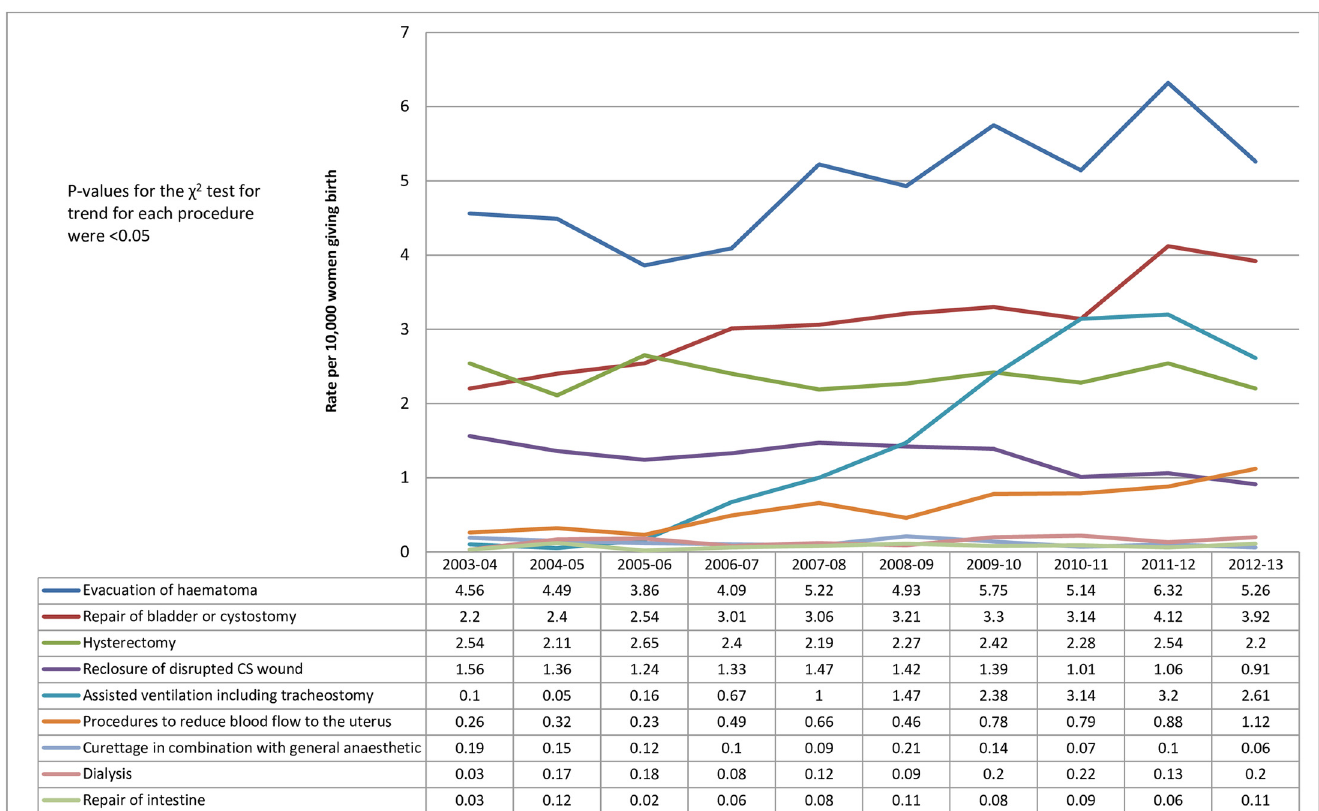
Fig 5. Annual rate per 10,000 women of the individual procedures included in the EMMOI (2003 to 2013); Hospital Episode Statistics data England.